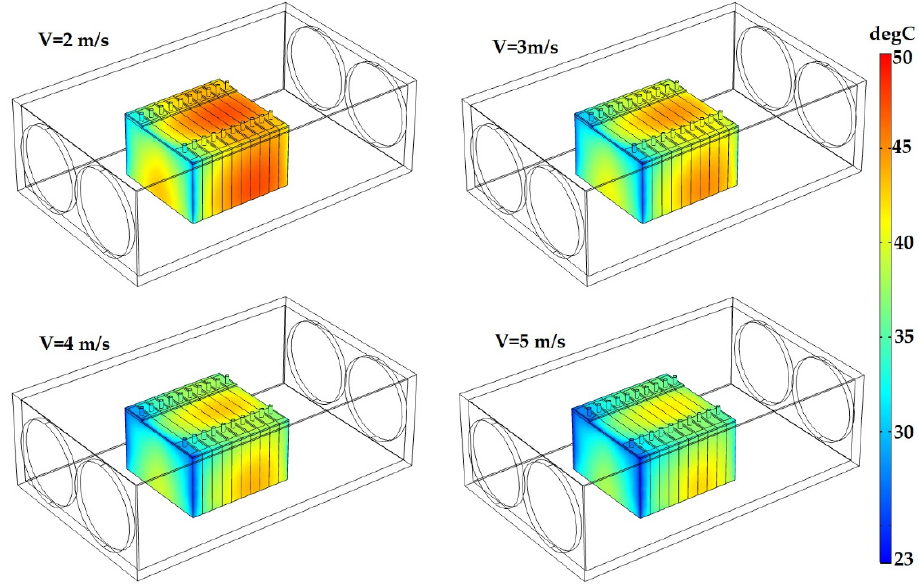
Figure 9. Temperature distribution of the LiC module for different inlet air velocities.